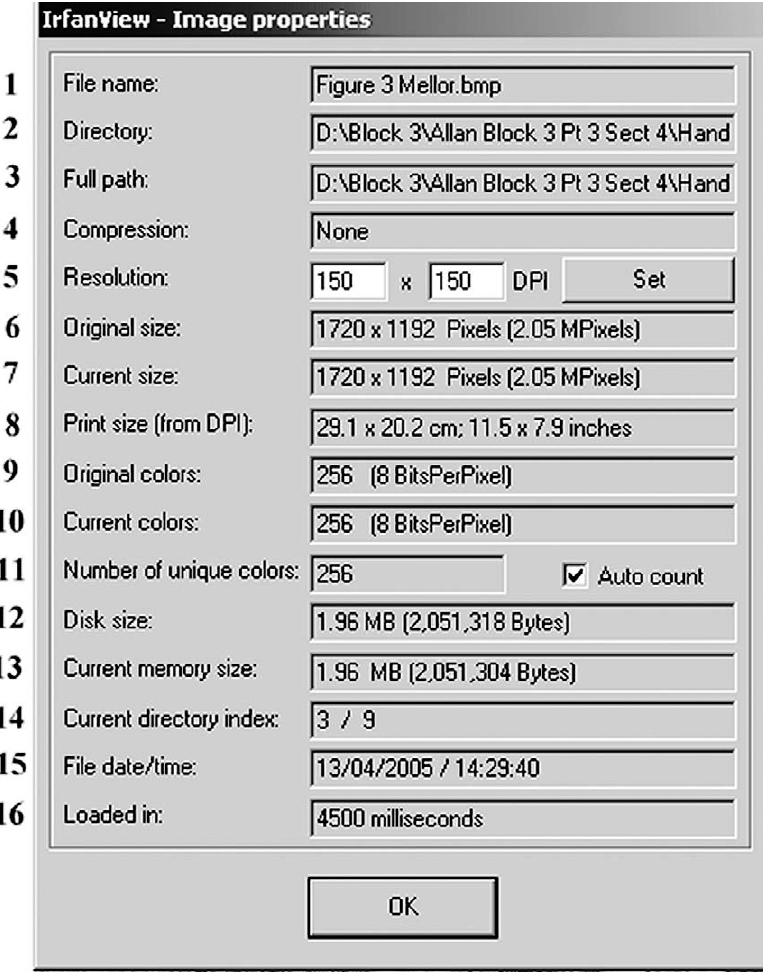
Figure 3. Image properties window of